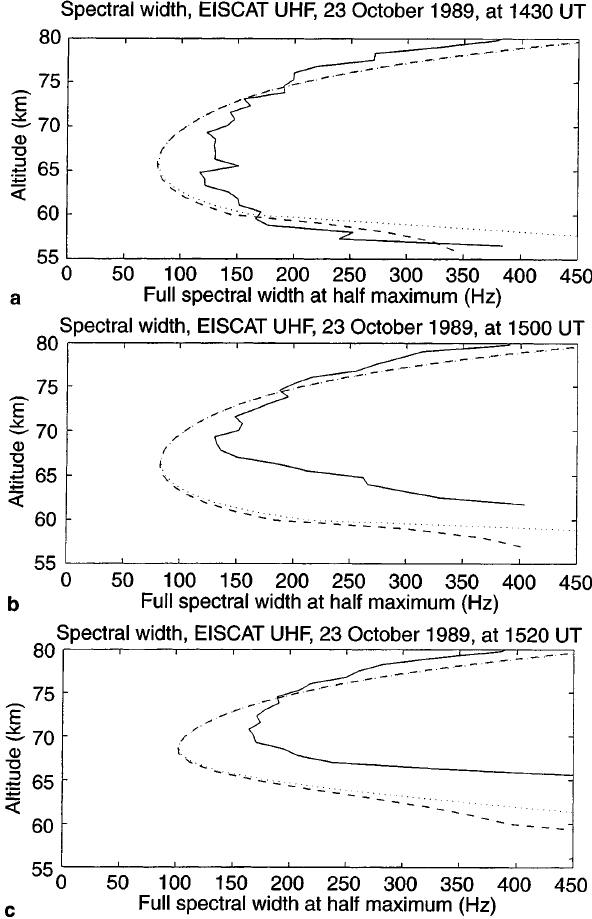
Fig. 6a–c. Observed spectral widths as functions of height ( solid lines ), and model results for full plasma calculation ( dashed lines ) and collisional approximation ( dotted lines ). a For 1430 UT, b for 1500 UT, and c for 1520 UT. See text for zenith angle dependence of the assumed photodetachment and photodissociation rates